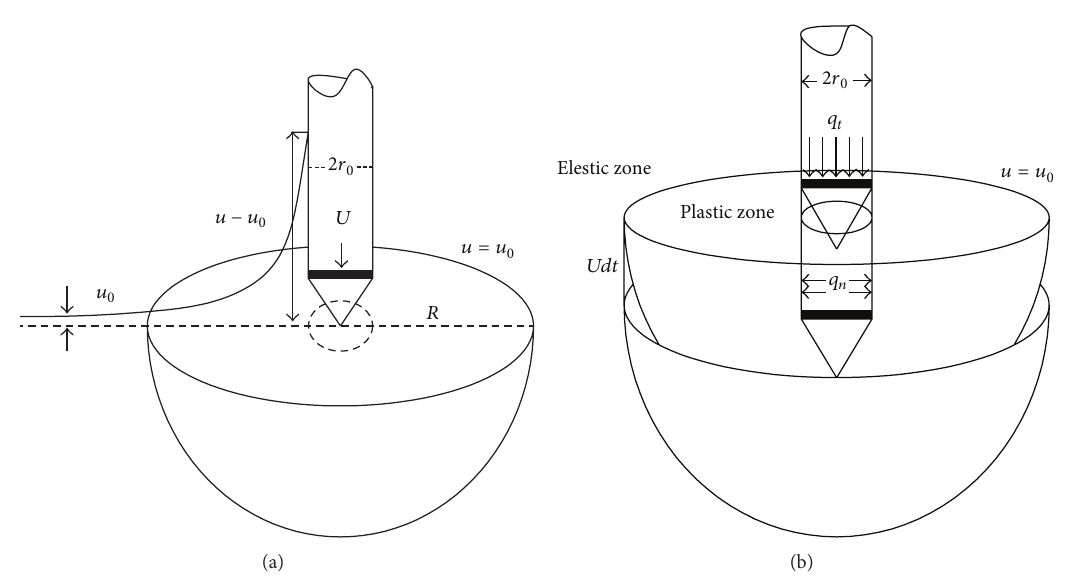
Figure 2: Geometry of process zone surrounding advancing penetrometer.